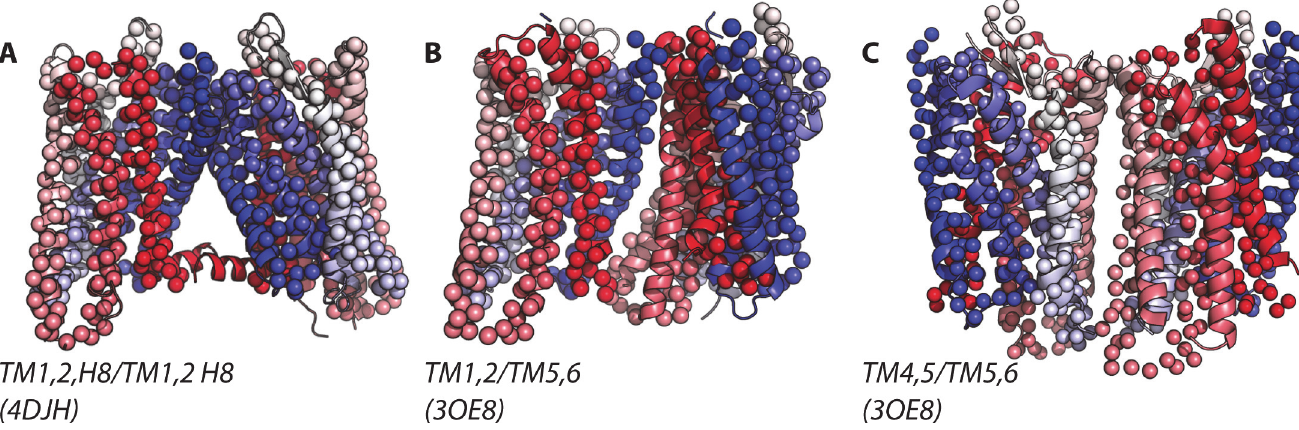
Fig 2. Superposition of the highly frequent homo-dimer configurations of δ -OR onto the closest available crystal structures of parallel receptors. Specifically, these are: TM1,2,H8/TM1,2,H8, TM1,2/TM5,6, and TM4,5/TM5,6, in panels A (RMSD of 3.57 Å from 4DJH), B (RMSD of 6.48 Å from 3OE8), and C (RMSD of 6.62 Å from 3OE8),